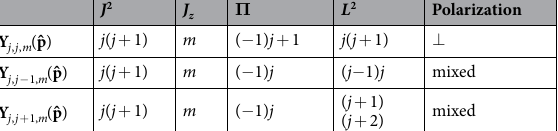
Table 2. Vector spherical harmonics: Polarization character and eigenvalues of J 2 , J z , Π , and L 2 . L 2 is the orbital angular momentum squared. Both j ≥ 0 and = − … m j j are integers. For j = 0, π = − ˆ Y p /(4 ) Y 0, − 1,0 is not